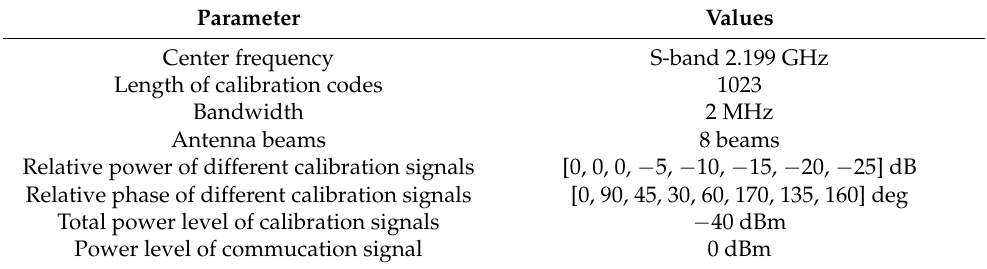
Table 1. System parameters.